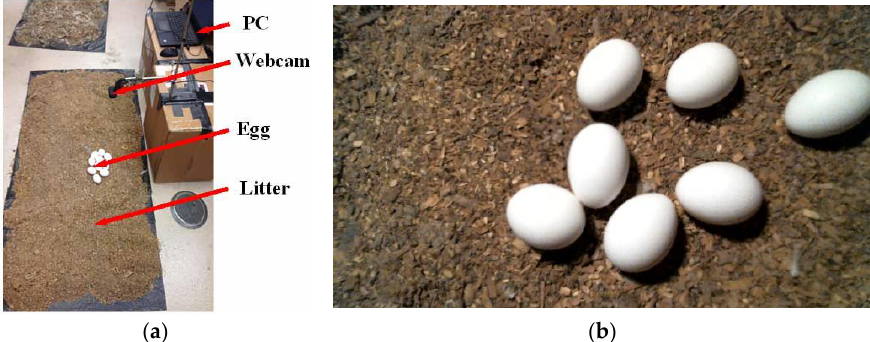
Figure 1. A photo of the imagery system setup ( a ) and a top-view sample image of floor eggs ( b ).